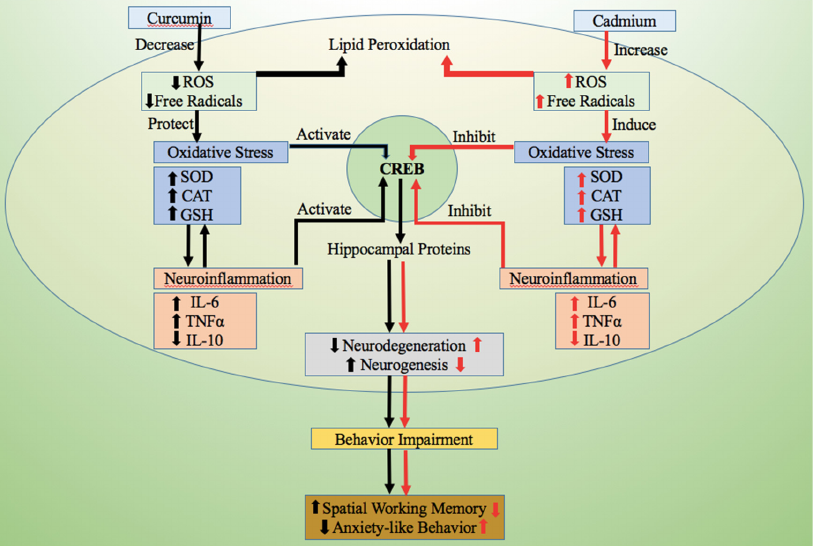
Figure 1. Diagrammatic illustration showing the pathway involved in the Cd-induced behavioral impairment ( right panel ) and the ameliorating effect of curcumin ( left panel ). Upon Cd exposure, the cellular reactive oxygen species (ROS) and free radicals increased, causing oxidative stress, as the cellular antioxidant enzymes (SOD, CAT, and GSH) decreased. Cd exposure also leads to neuroinflammation by increasing the cellular pro-inflammatory markers (IL-6 and TNF α ). This causes behavioral impairment and acceleration of neurodegeneration. On curcumin treatment, cellular oxidative stress and neuroinflammation decreased, thereby promoting hippocampal neurogenesis and restoring mice behavior. Reactive oxygen species (ROS), cadmium (Cd), superoxide dismutase (SOD), catalase (CAT), glutathione (GSH), interleukin-6 (IL-6), tumor necrosis factor alpha (TNF α ). (Image source BioRender.com; accessed on 28 August 2021). The prefrontal cortex regulates and controls a variety of higher cognitive functions including thinking, planning, reasoning, and decision making [17]. Moreover, recent findings suggest that this region of the brain also regulates the formation of short-term spatial working memory and anxiety-like cognitive behavior [18]. However, the effect of Cd on the prefrontal cortex of the brain region has not been studied. Therefore, the main